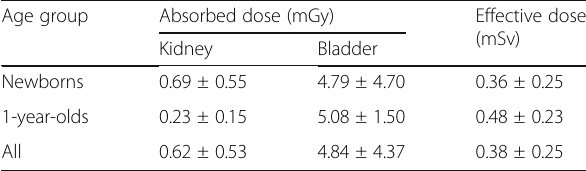
Table 2 Mean absorbed doses and effective doses for both age groups